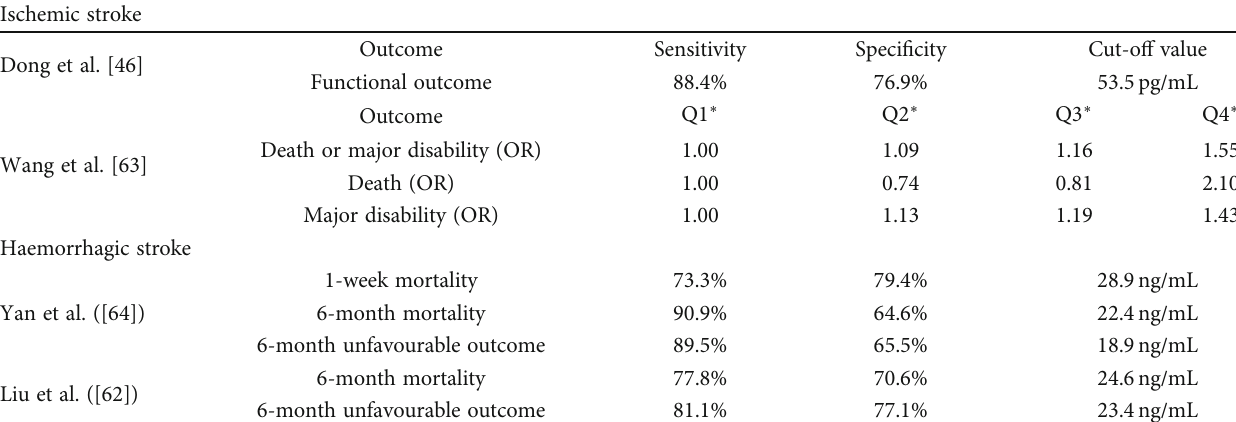
Table 2: Association of plasma Gal-3 levels with stroke